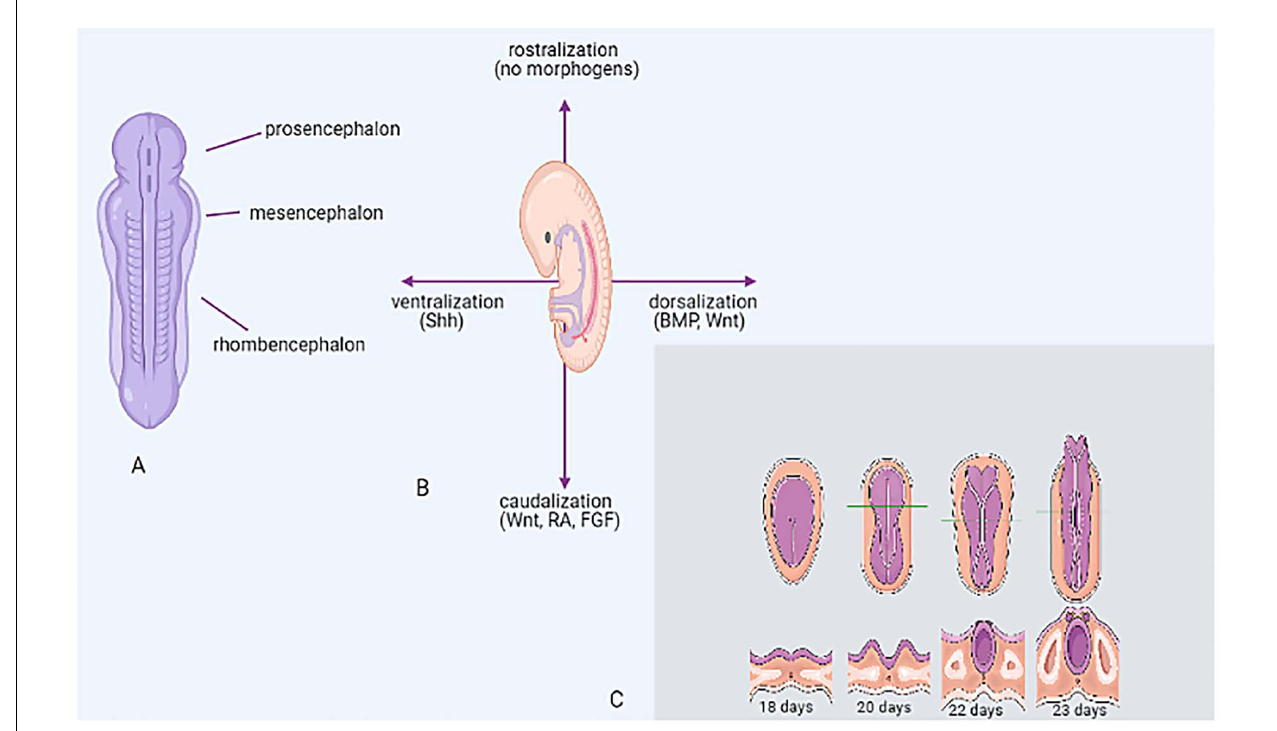
FIGURE 1 | CNS embryology. (A) Brain vesicles giving rise to prosencephalon, mesencephalon, rhombencephalon (axial view). (B) Establishment of axes through morphogen gradient, in vivo (lateral view). (C) Embryogenesis of the neural tube around a fluid-filled lumen and development of brain vesicles at 18, 20, 22, and 23 days. BMP, bone morphogenetic protein; FGF, fibroblast growth factor; RA, retinoic acid; SHH, sonic